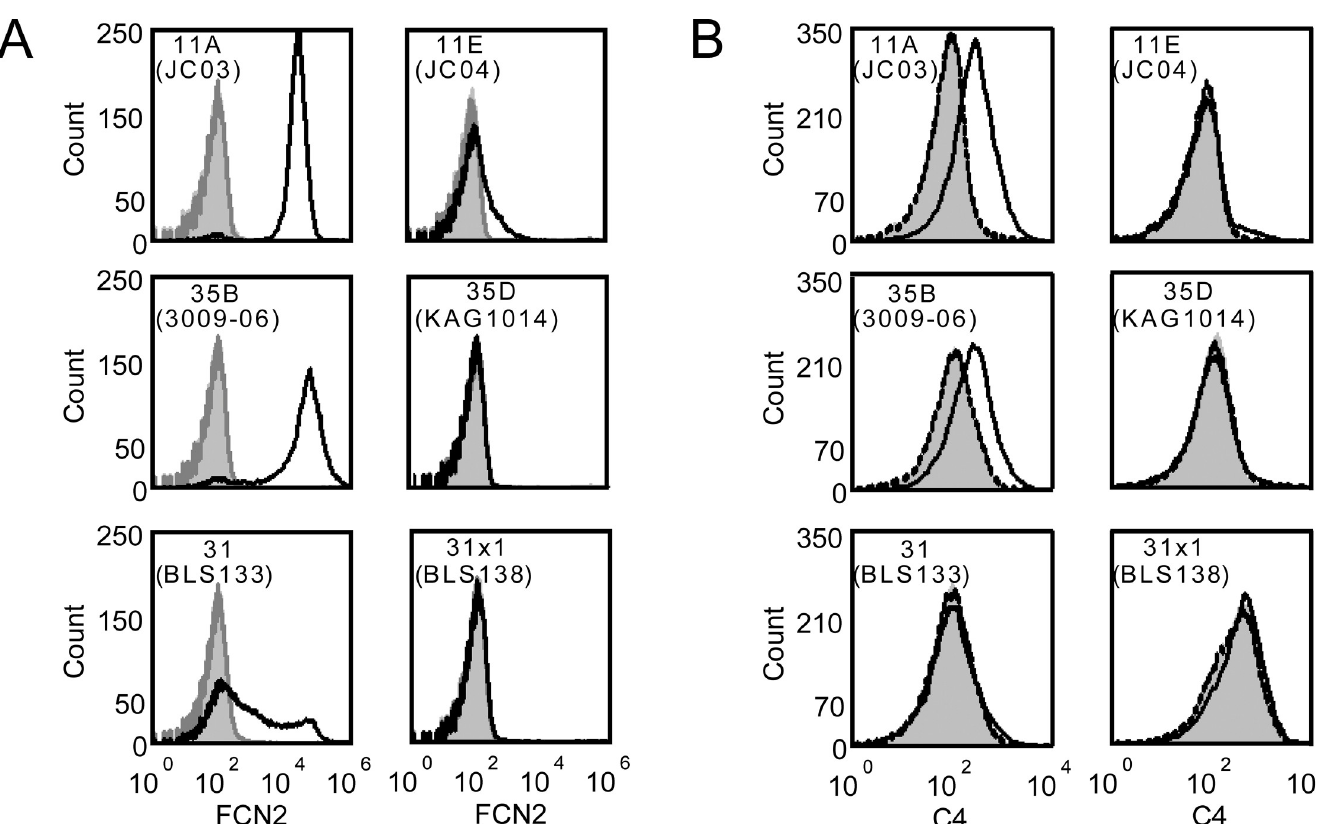
Fig 3. Studies of ficolin-2 binding and ficolin-2-mediated complement deposition. A, ficolin-2 (FCN2) binds to representative serotype 11A, 35B, and 31 strains but not their isogenic O-acetyl transferase-deficient derivatives (11E, 35D, and 31X1). Bacteria were incubated with buffer (light gray fill), 10% heat-inactivated normal human serum (dark gray line), or 10% normal human serum (black line) for 1 hour at 4˚C. After incubation, cells were stained with a ficolin-2-specific antibody and analyzed by flow cytometry. B, ficolin-2 stimulates complement deposition on serotypes 11A and 35B but not serotype 31. Bacteria were pre-incubated with buffer (light gray shading), recombinant ficolin-2 (solid black line), or heat-inactivated recombinant ficolin-2 (dashed black line). After washing, bacteria were incubated with 10% C1q-depleted serum (C1q-dpl). Complement fragment C4 degradation products (C4b and C4c) were detected with antibodies and assayed by flow cytometry. Ficolin-2 alone (not shown) did not elicit complement